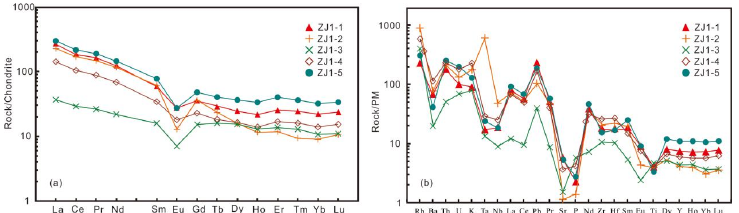
Figure 8. Chondrite-normalized REE patterns ( a ) and primitive mantle normalized spider diagrams ( b ) [52] (after Sun and McDonough, 1989).